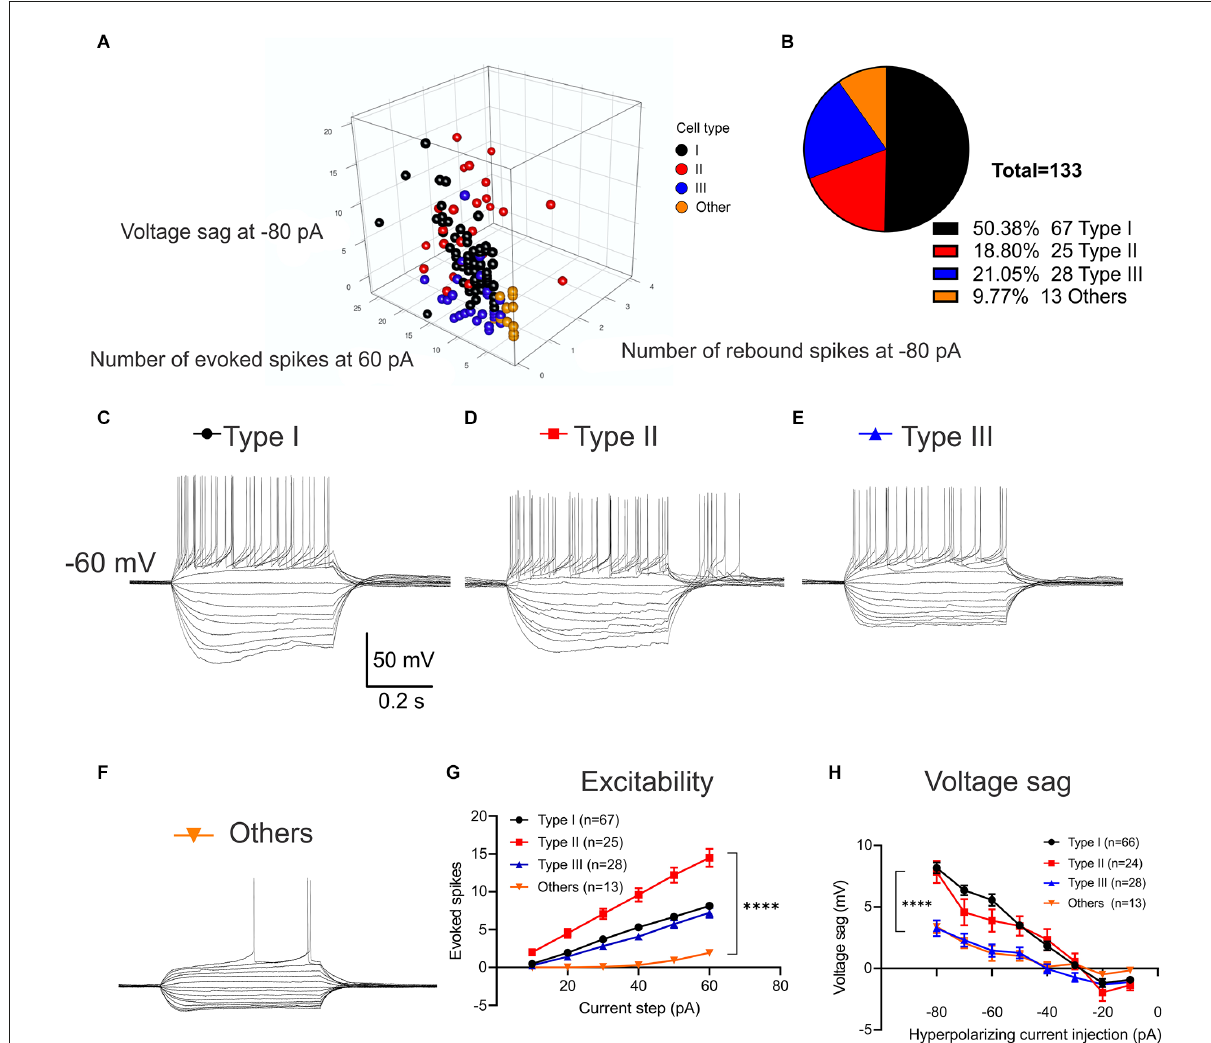
FIGURE2 Classification of VTA-projecting BNST neuron activity in response to a series of current injections. Neurons were preliminarily clustered according to firing phenotypes; including excitability, voltage sag and the presence of a rebound spike following hyperpolarization. (A) 3D scatter plot of raw values summarizing clusters ( n = 131 neurons from N = 22 mice). (B) Pie chart showing the percentage of VTA-projecting BNST neurons categorized by neuronal type ( n = 133 neurons from N = 22 mice). (C) Sample traces of voltage response to current steps from − 80 pA to +60 pA for 500 ms in Type I neurons. (D) Type II neurons with rebound burst at termination of hyperpolarizing current injection. (E) Type III neurons without voltage sag. (F) Another type of Type “Others” neurons with late firing. Scale bar: 50 mV and 0.2 s. (G) Type II neurons exhibit higher number of spikes with the same size current injection compared to Type I, III, and Type “Others” neurons. A two-way ANOVA revealed a significant interaction between the effect of types and current steps on the number of evoked spikes, F (15,774) = 6.308, P < 0.0001. Tukey post- hoc test revealed that Type II neurons had significantly higher number of evoked spikes at 20–60 pA current injection than other three neuron types (adjusted P = 0.0006, vs. Type I; adjusted P = 0.0004, vs. Type III; adjusted P = < 0.0001, vs. Type “Others” at 20 pA; adjusted P < 0.0001, vs. Type I; adjusted P < 0.0001, vs. Type III; adjusted P < 0.0001, vs. Type “Others” at 60 pA). (H) Type I and Type II neurons exhibit a significantly larger voltage sag compared to Type III and Type “Others.” A two-way ANOVA revealed that there was a significant interaction between the effect of types and current steps on voltage sag, F (21,1016) = 4.634, P < 0.0001. Tukey post-hoc test revealed that Type I neurons had significantly larger voltage sag (mV) than Type III and Type “Others” at − 80 pA through − 50 pA steps (adjusted P < 0.0001, vs. Type III; adjusted P < 0.0001,